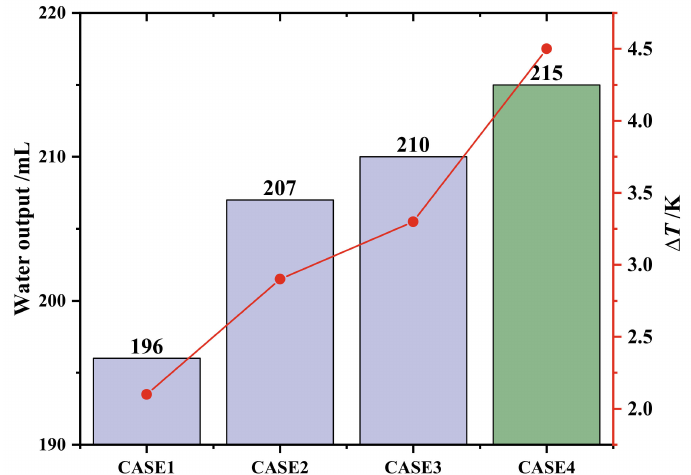
Figure 11. Water output and ∆ T under different arrangements of